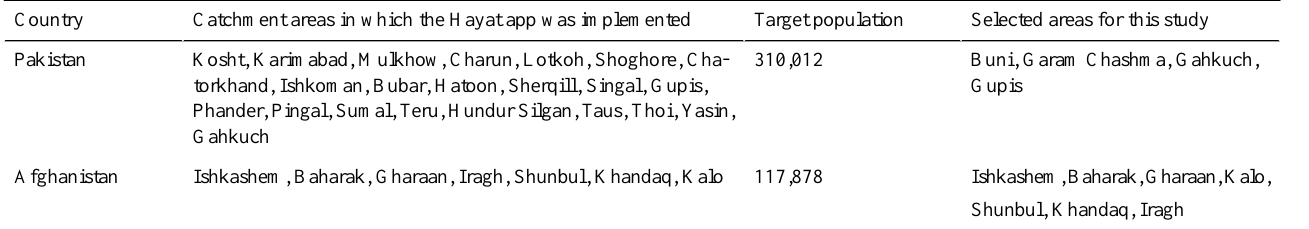
Table 1. Districts in which the Hayat ap was implemented.